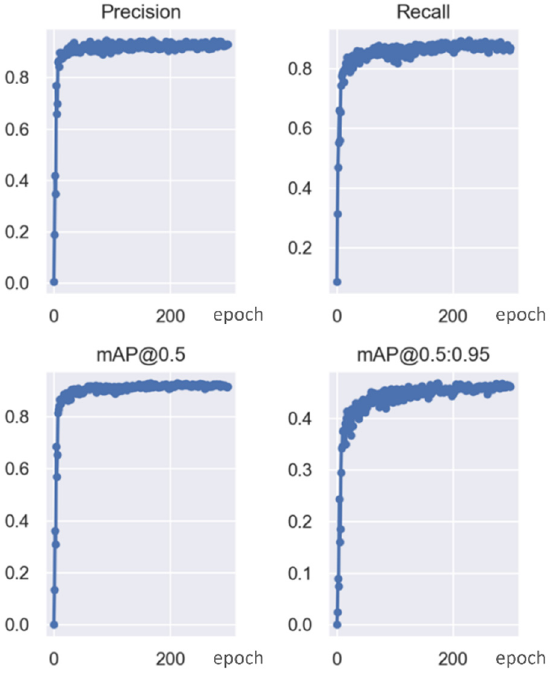
Figure 9. Precision, recall, mAP changes, and convergence process during training.